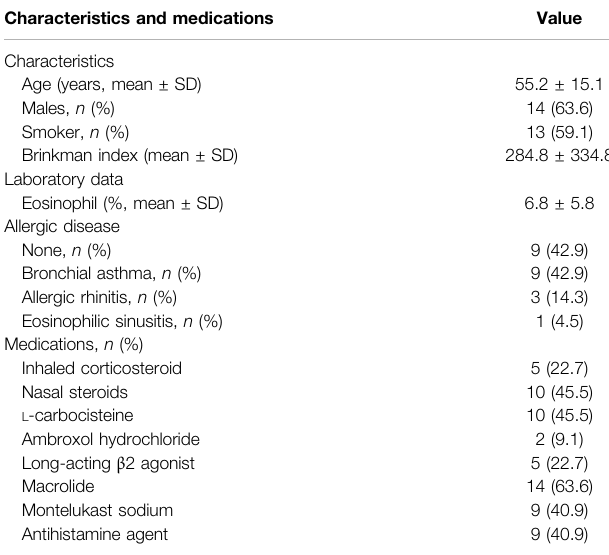
TABLE 1 | Patient characteristics ( n (cid:2)